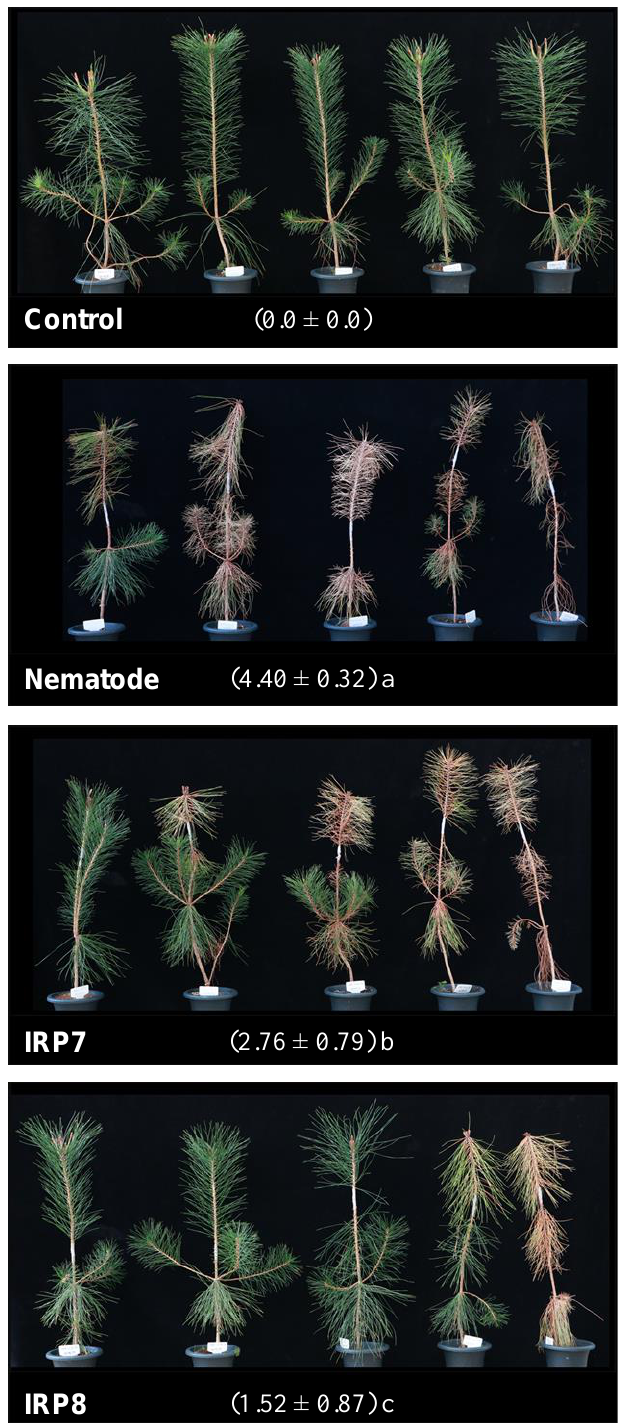
Figure 1. Effect of resistance-inducing bacterial treatment on pine wilt disease. Control, Untreated and uninoculated pine seedlings; Neamtode, pine seedlings inoculated with nematode, Bursaphe- lenchus xylophilus ; IRP7, nematode-inoculated pine seedlings treated with Pseudomonas koreensis IRP7; IRP8, nematode-inoculated pine seedlings treated with Lysobacter enzymogenes IRP8. Disease severity at 30 days post-inoculation is presented under each photograph as the mean ± standard deviation of five replicates; different lowercase letters following the disease severity indicate statistical significance at p < 0.05 according to the least significant difference